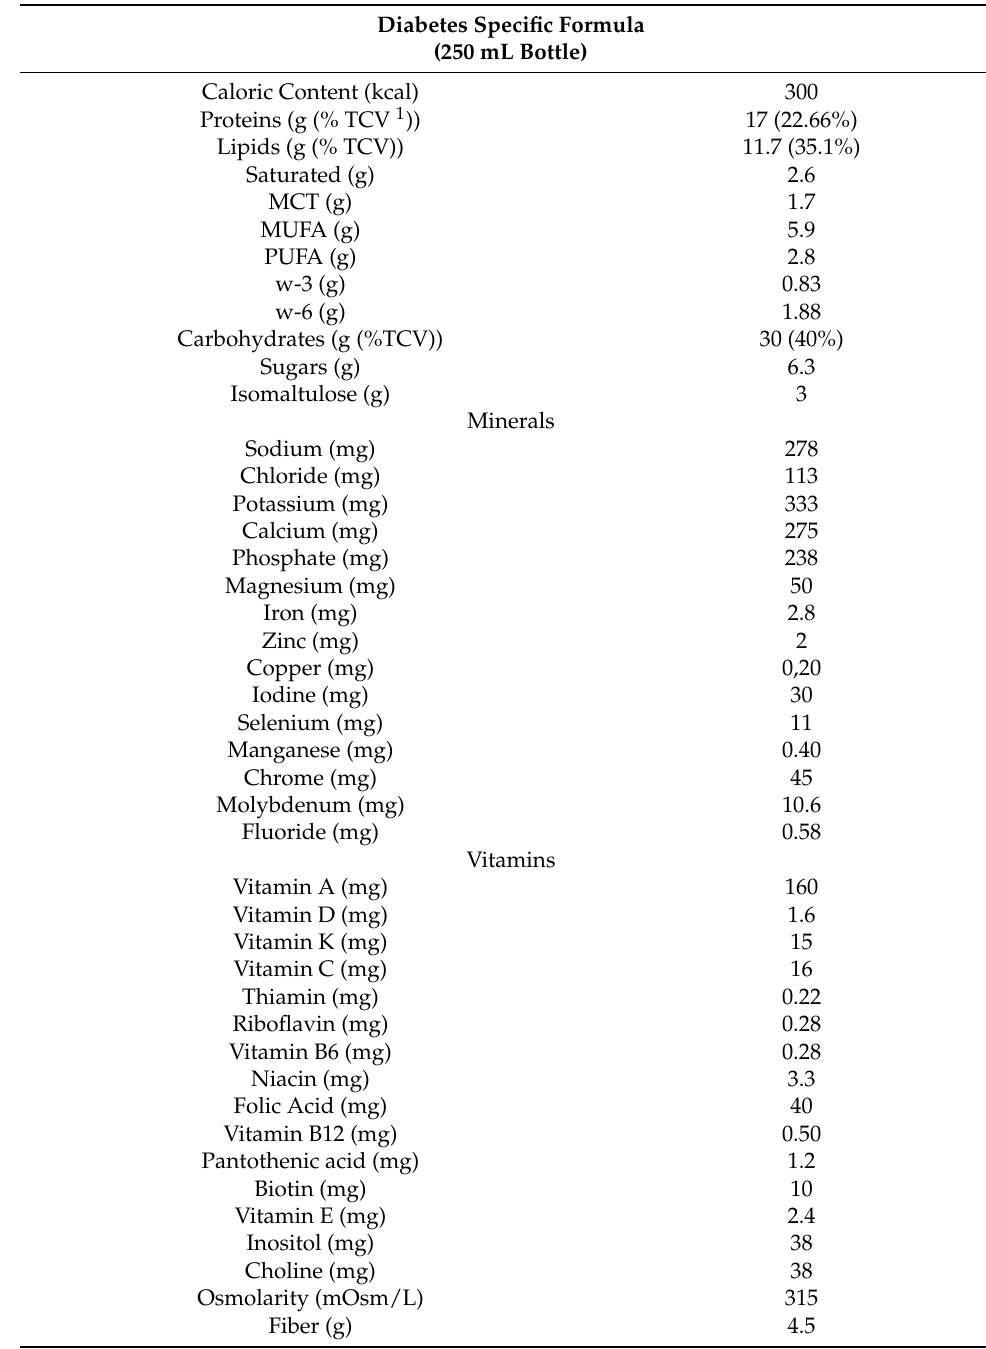
Table 1. Composition of Specific Diabetes Formula used as